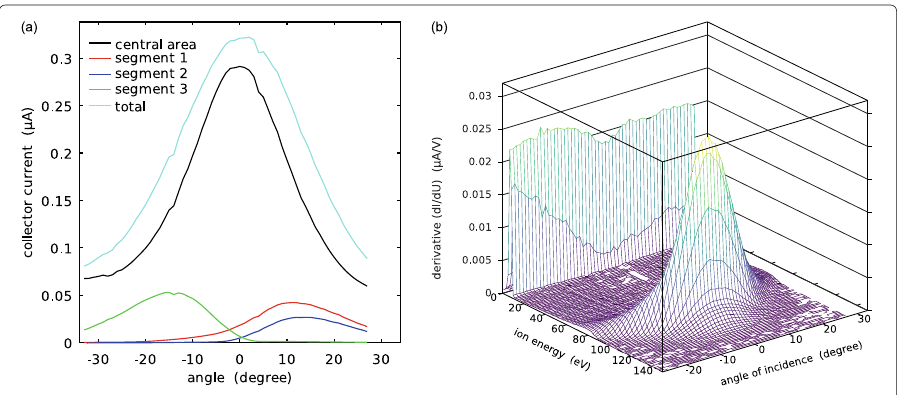
Fig. 12 Directivity of the RPA. (a) Collector currents onto the four segments versus angle of incidence, (b) IEDFs versus angle of